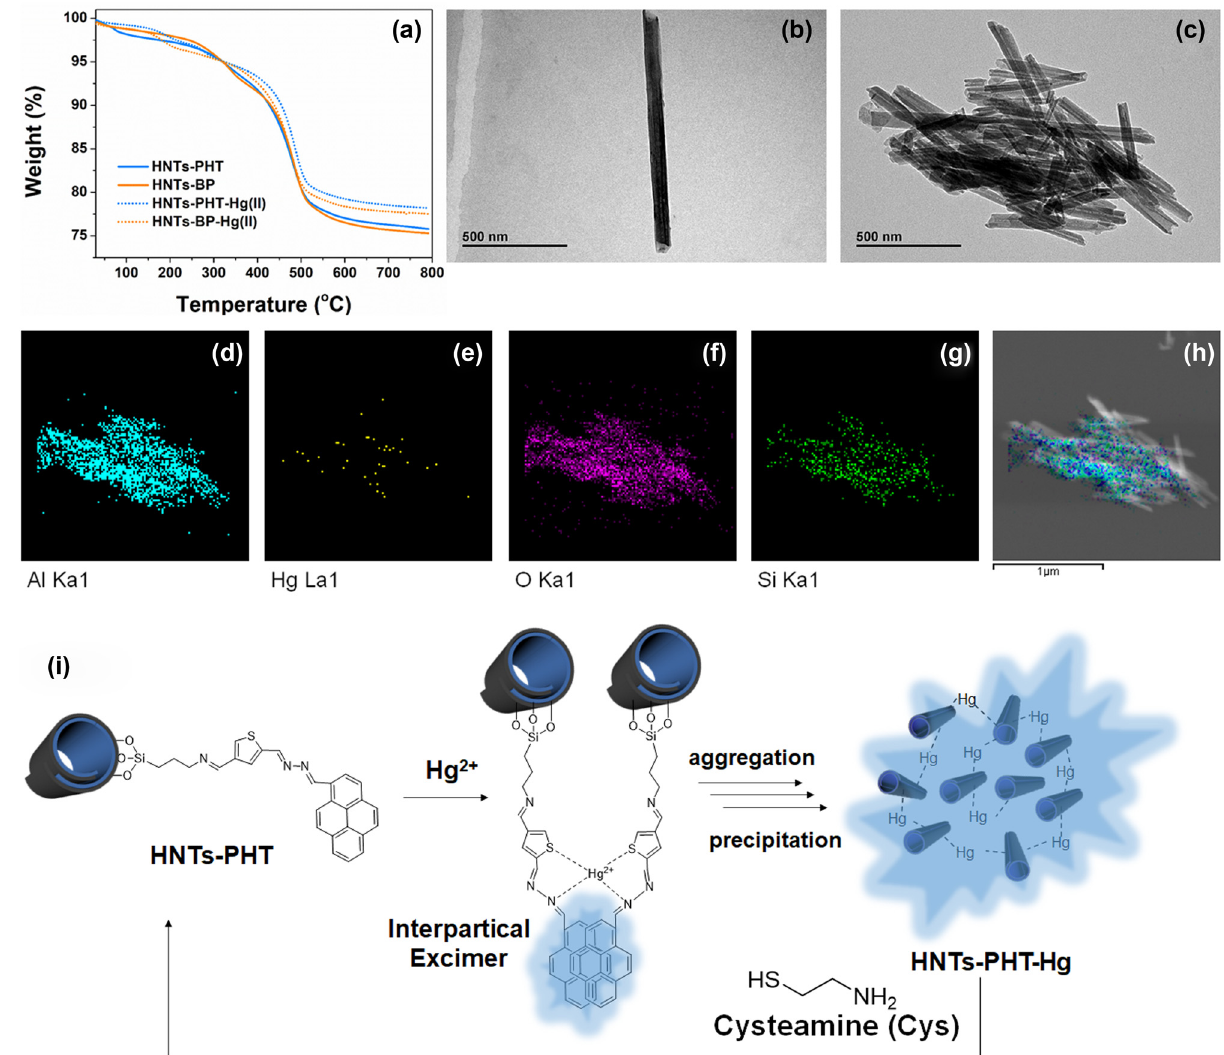
Figure 6: Absorption studies. [( a ) TGA curves of HNTs - PHT, HNTs - BP, HNTs - PHT - Hg ( II ) and HNTs - BP - Hg ( II ) ; ( b ) TEM image of HNTs - PHT; ( c ) TEM image of HNTs - PHT - Hg ( II ) ; ( d ) EDS mapping of Al; ( e ) EDS mapping of Hg; ( f ) EDS mapping of O; ( g ) EDS mapping of Si; ( h ) mixture of